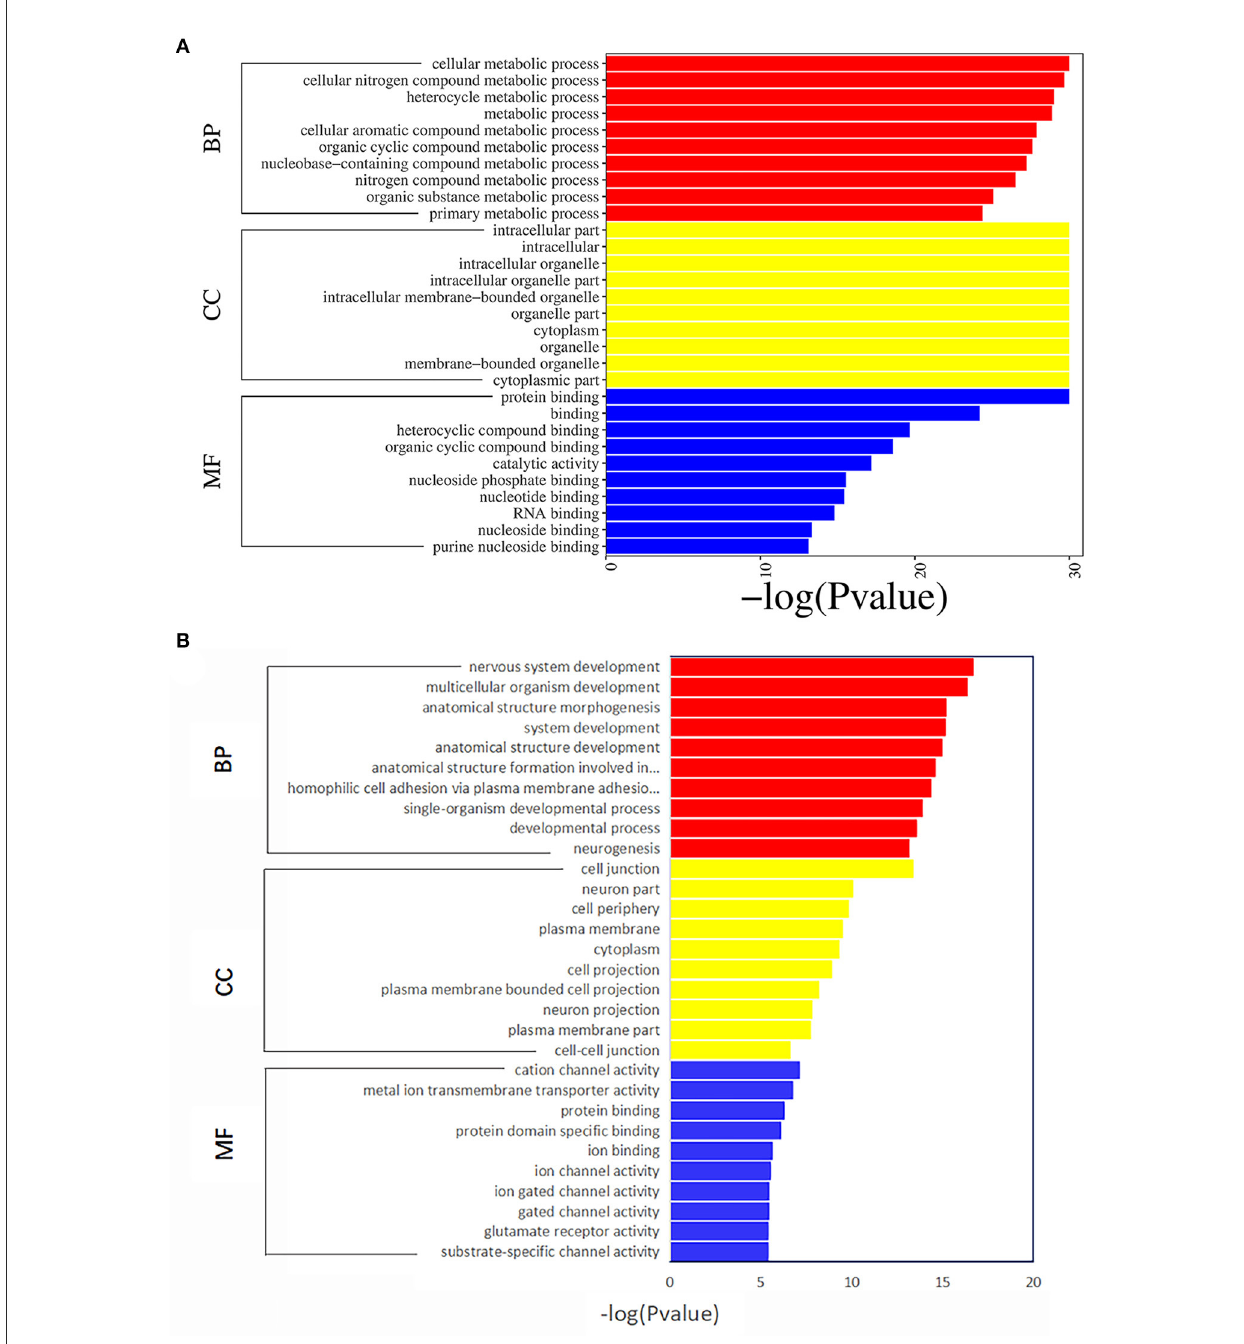
FIGURE3 The top 10 enriched Gene Ontology terms for differentially expressed mRNAs (A) and DNA methylation positions (B) in first-episode, drug-naive adolescents with MDD. BP, biological processes; CC, cellular components; MF, molecular functions.